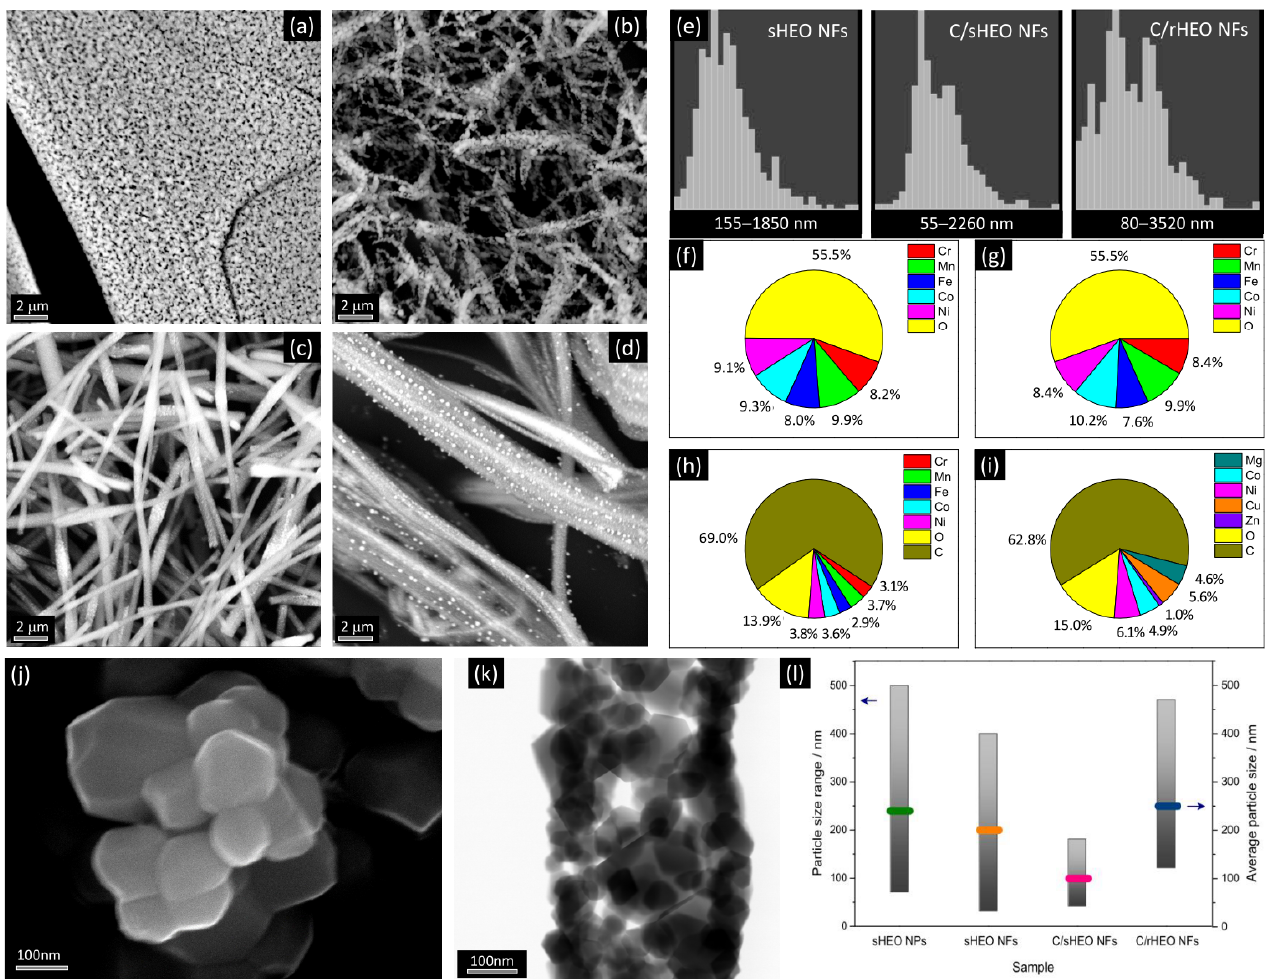
Figure 1. Main results of the morphological and compositional analyses. ( a – d ) Representative SEM images of ( a ) sHEO NPs, ( b ) sHEO NFs, ( c ) C/sHEO composite NFs, and ( d ) C/rHEO composite NFs. ( e ) Diameter distribution of electrospun NFs. ( f – i ) Elemental composition of ( f ) sHEO NPs, ( g ) sHEO NFs, ( h ) C/sHEO NFs, and ( i ) C/rHEO NFs. ( j , k ) TEM images of ( j ) sHEO NPs and ( k ) sHEO NFs. ( l ) Size and size range of HEO NPs in the samples. The left arrow is located in correspondance of the grey bar and indicates that the y-axis for bars is on the left (particle size range); the right arrow is located in correspondance of the blue symbol and indicates that the y-axis for coloured symbols is on the right (average particles